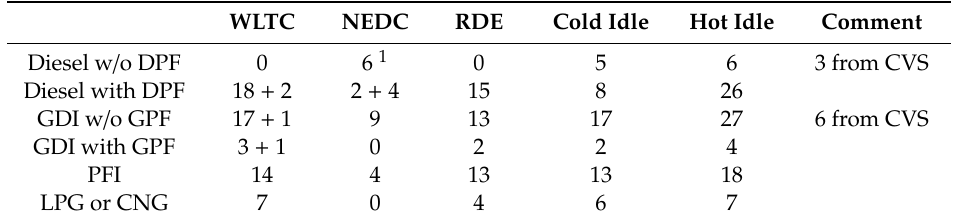
Table 1. Summary of available vehicles. Number after “ + ” are vehicles from literature (dedicated new PTI